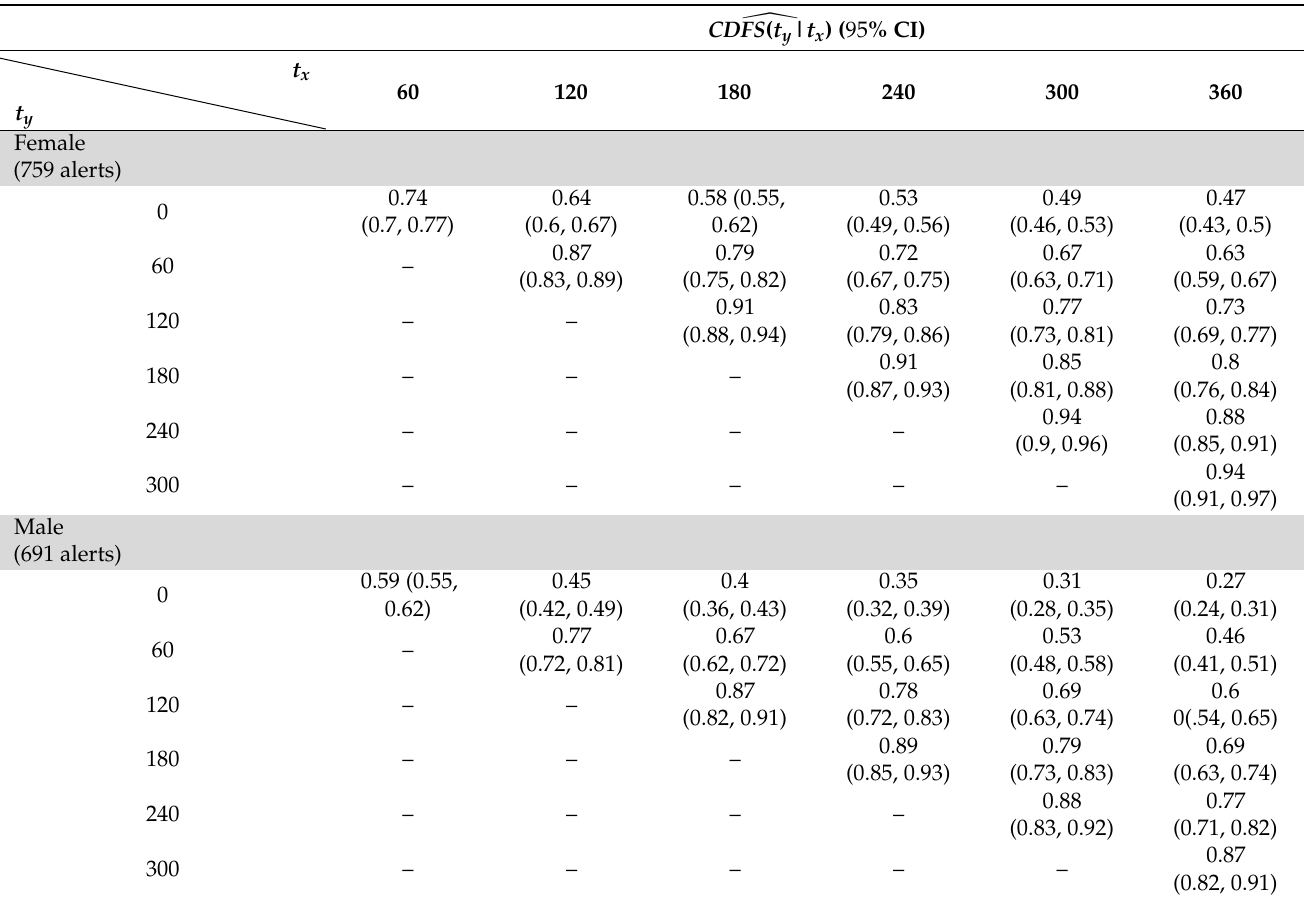
Table 2. An overview of the estimated conditional defect free survival probabilities stratified by gender, and their corresponding 95% confidence intervals (CI) to various timestamps in minutes t y , conditional onAPA being defect free until timestamps t x upon triggering the alert. Note: t x = 0 denotes baseline time, i.e., the time of alert generation.